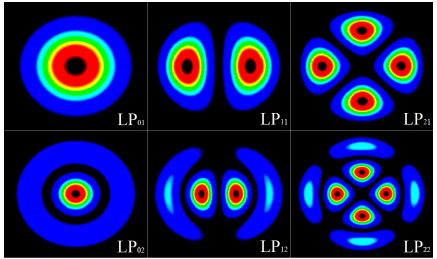
Figure 3. Intensity profile distributions of ideal LP spatial modes.